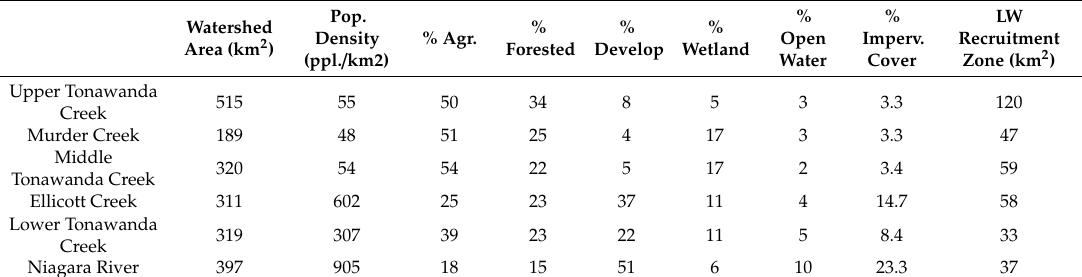
Table 1. Area, population density, and land cover information for each of the six study watersheds. LW Recruitment Zone = 30 m bu ff er of the stream channel [27].